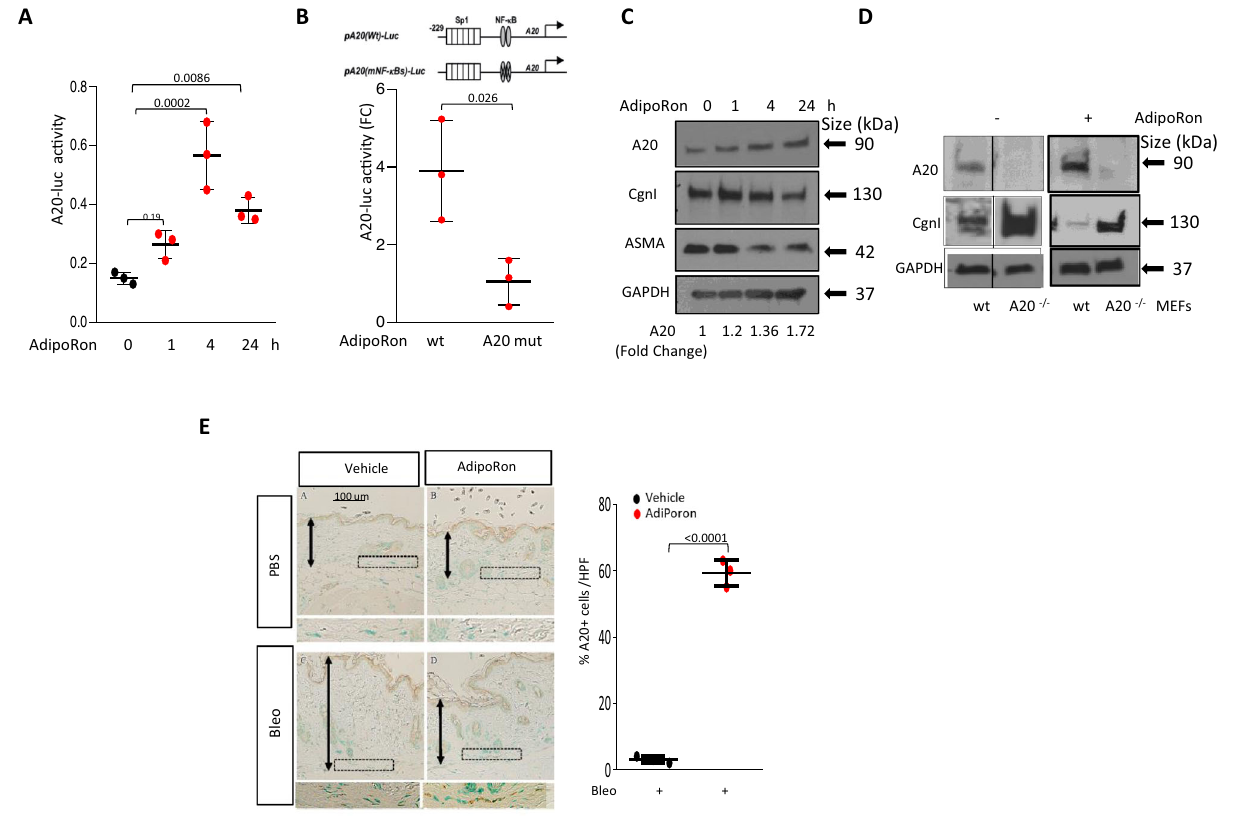
Fig. 8 | Adiponectin receptor agonist adiporon induces a20 expression in explanted fi broblasts and in mice. A , B Normal skin fi broblasts transiently transfectedwithA20-luc( A )oranNF- κ BbindingsitemutatedA20( B )promoter-luc were incubated with AdipoRon (10 μ g/ml) for indicated periods ( A ) or for 4h ( B ), and whole-cell lysates were assayed for their luciferase activities. Results, normal- izedwithRenillaluciferase( n =3),shownasmean±SDoftriplicatedeterminations. C Left panels: Fibroblasts were incubated with AdipoRon (10 μ g/ml) for indicated periods,and whole-celllysateswere examined by immunoblotting. Representative immunoblots ( n =2). A20 levels, normalized for GAPDH, are shown below each